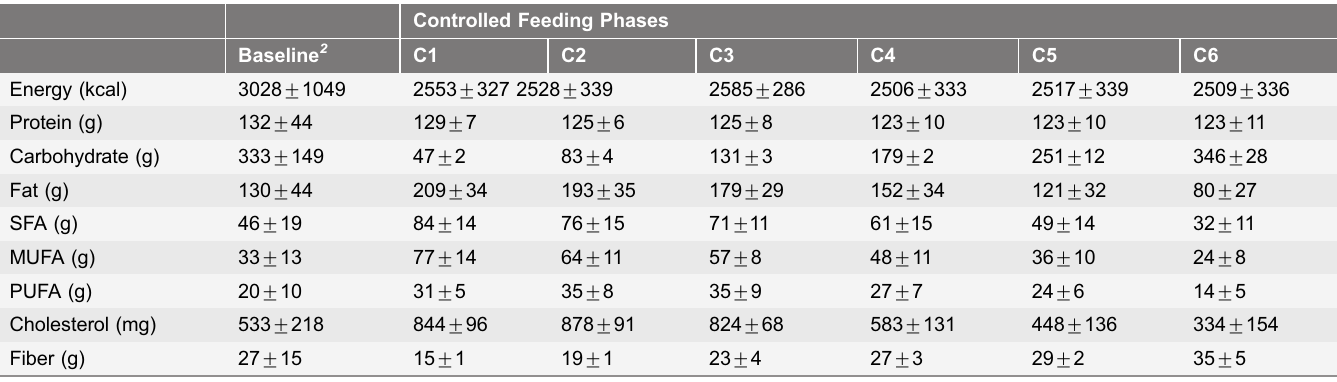
Table 2. Daily nutrient intakes at baseline (habitual diet) and during each dietary phase 1